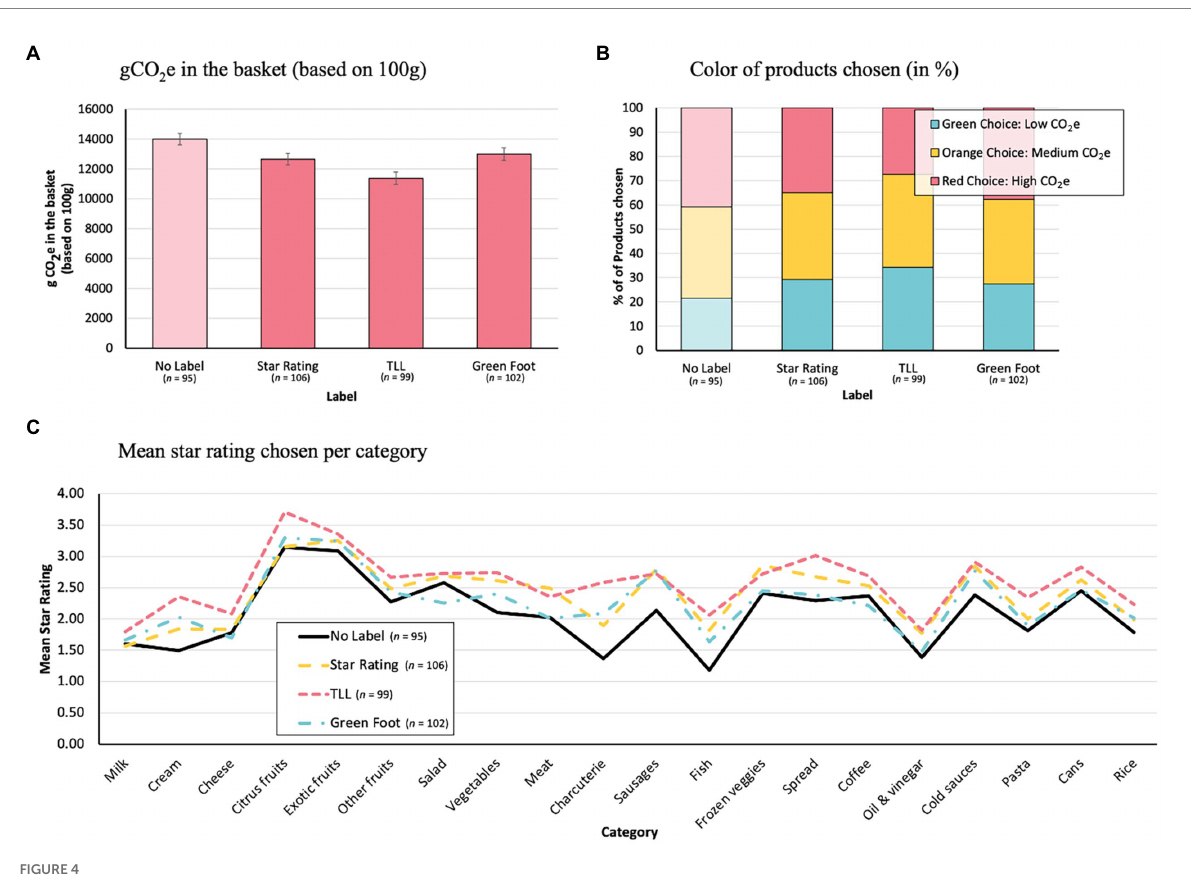
FIGURE 4 Results of the different outcome measures: (A) gCO 2 e of the products (based on 100g) in the shopping basket, (B) color of the product chosen in %, (C) mean star rating of the products chosen in each